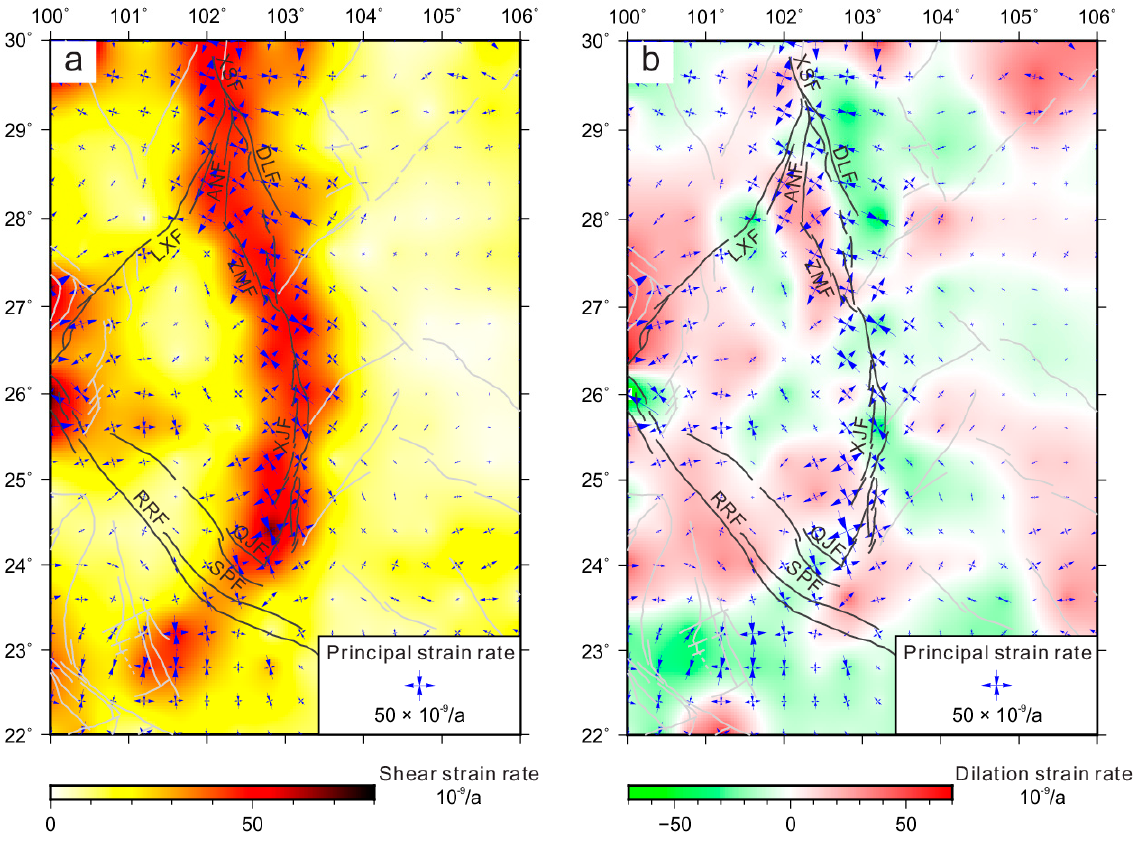
Figure 6. Strain rate distribution calculated from the combined GNSS velocity field. The horizontal strain rate axes indicate principal strain rate tensors. Abbreviations: LXF, Lijiang–Xiaojinhe fault. ( a ) The principal strain rate and shear strain rate. The background colors represent the shear strain rate. ( b ) The principal strain rate and dilation strain rate. The background colors represent the dilation strain rate.